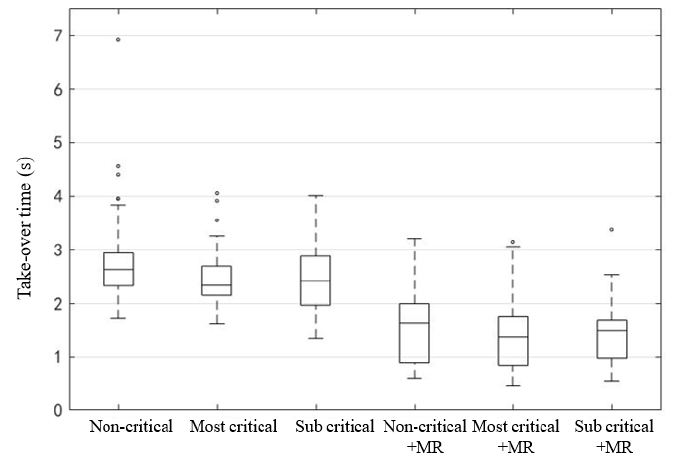
Figure 11. Takeover time of six scenarios.